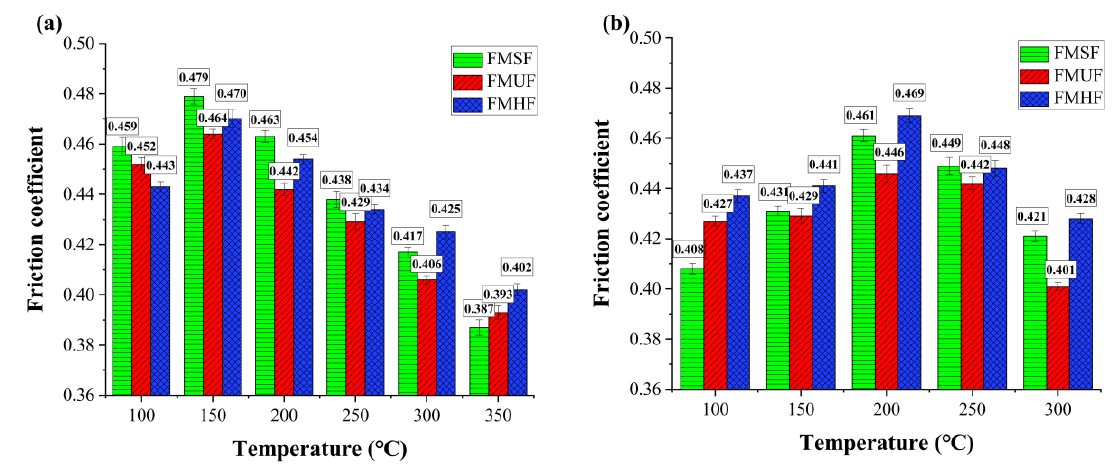
Figure 5. Friction performance of the developed composite materials in ( a ) fade testing and ( b ) recovery testing.